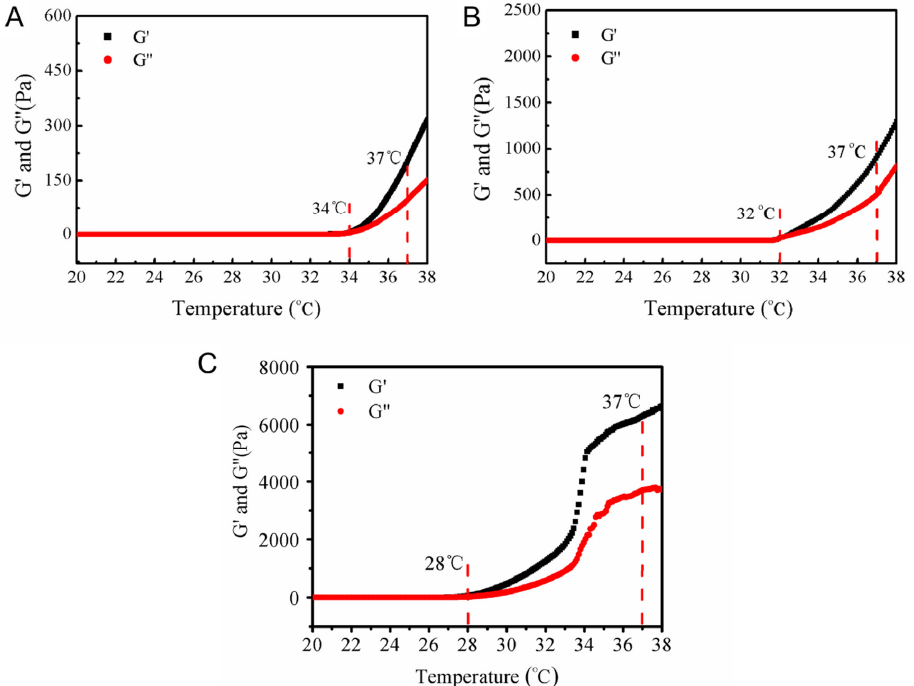
Figure 3. Rheological studies of PF108 hydrogels with different concentrations of PF108: ( A ) 15%, ( B ) 20%, and ( C ) 25% ( w / v ).